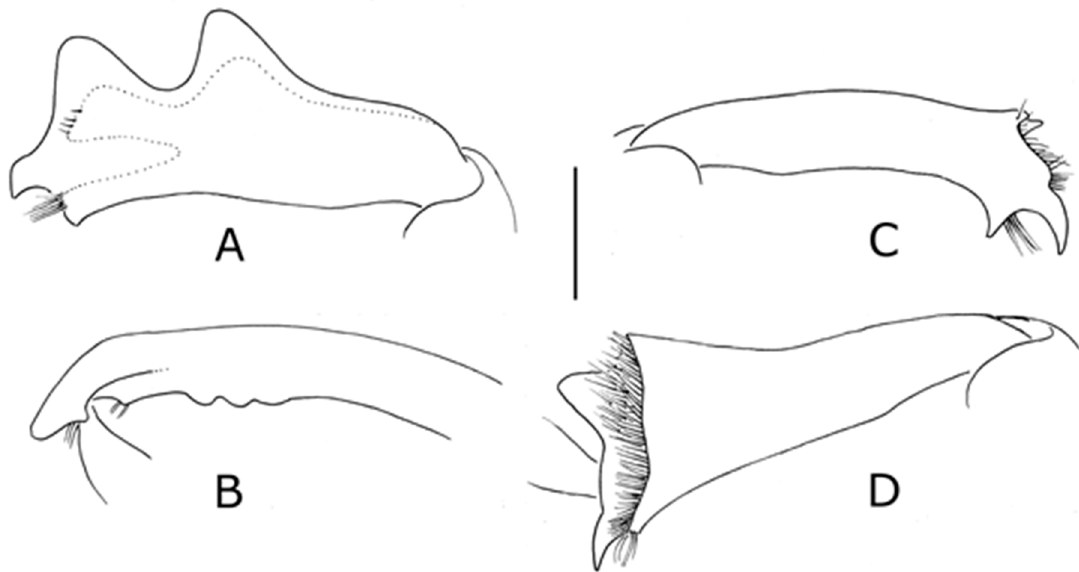
Figure 20. Sclerocardius indicus Hartmann, tibiae: ( A ) Fore tibia, right dorso-posterior (dotted line indicates smooth asetose areas), ( B ) fore tibia, anterior, showing postero-ventral teeth of male, ( C ) mid tibia, anterior left, and ( D ) hind tibia, anterior. Scale bar = 1 mm.